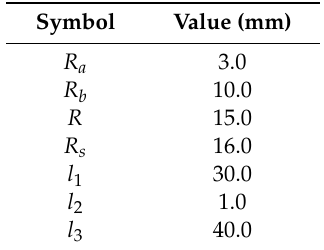
Table 1. Dimensions of the